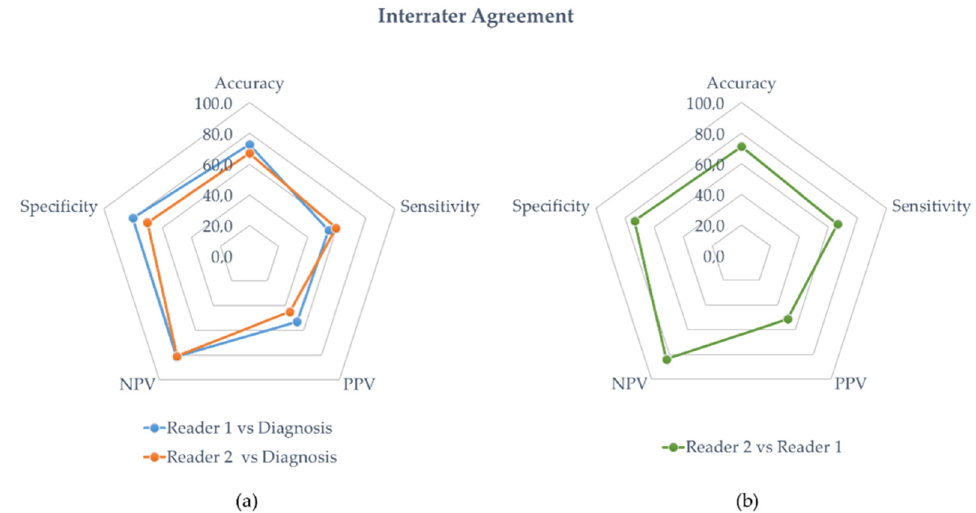
Figure 4. ( a ) Interrater agreement with diagnosis. The blue and orange line represent the diagnostic performances of the experienced physician (reader 1) and the student (reader 2), respectively. ( b ) Interrater agreement of the student’s diagnostic performances against the experienced physician (green line).